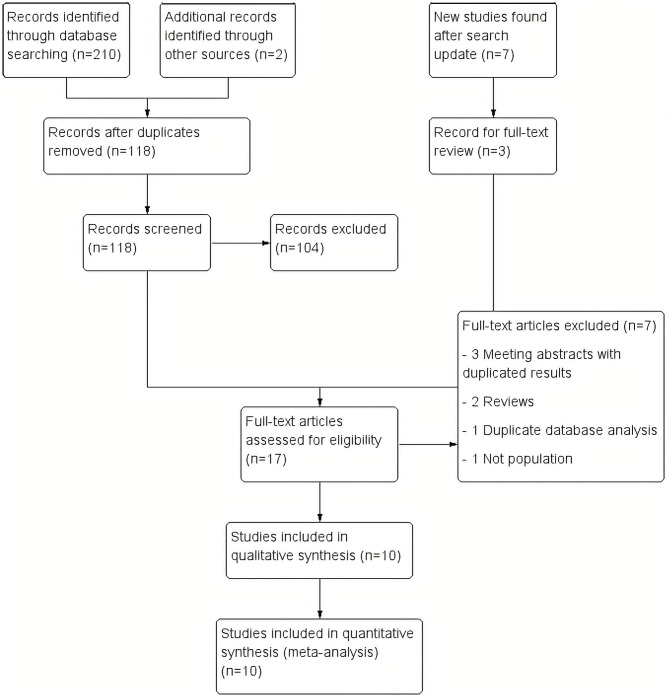
Study flow diagram. We included 210 records in the initial review, 7 more in the updated review and 2 more from other sources. Finally, we included 10 studies in the synthesis.